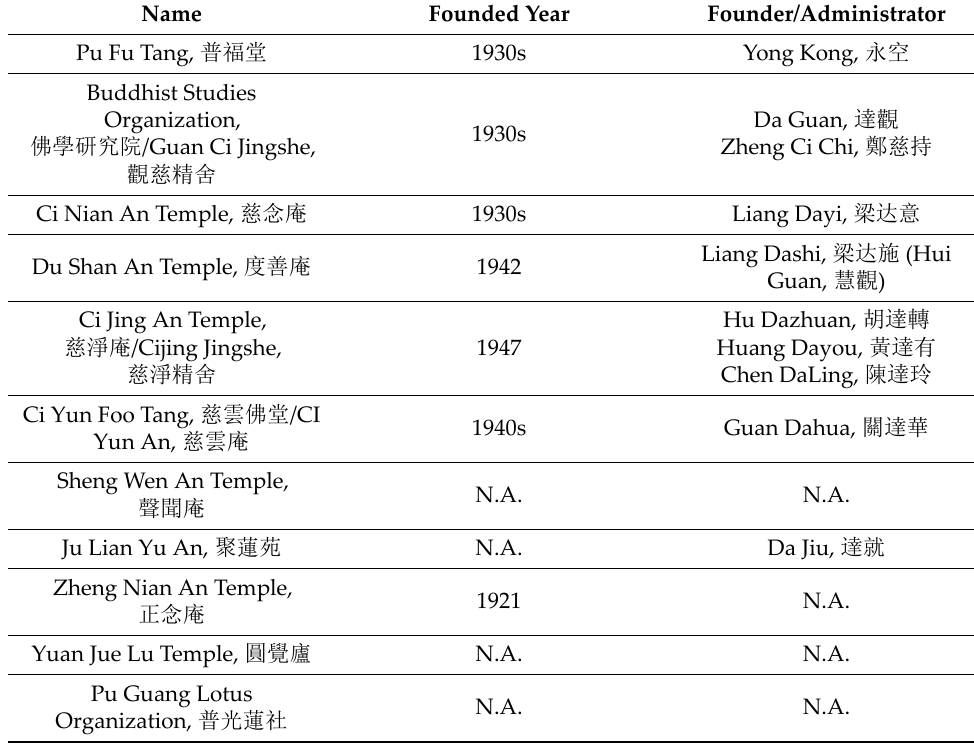
Table 3. List of vegetarian